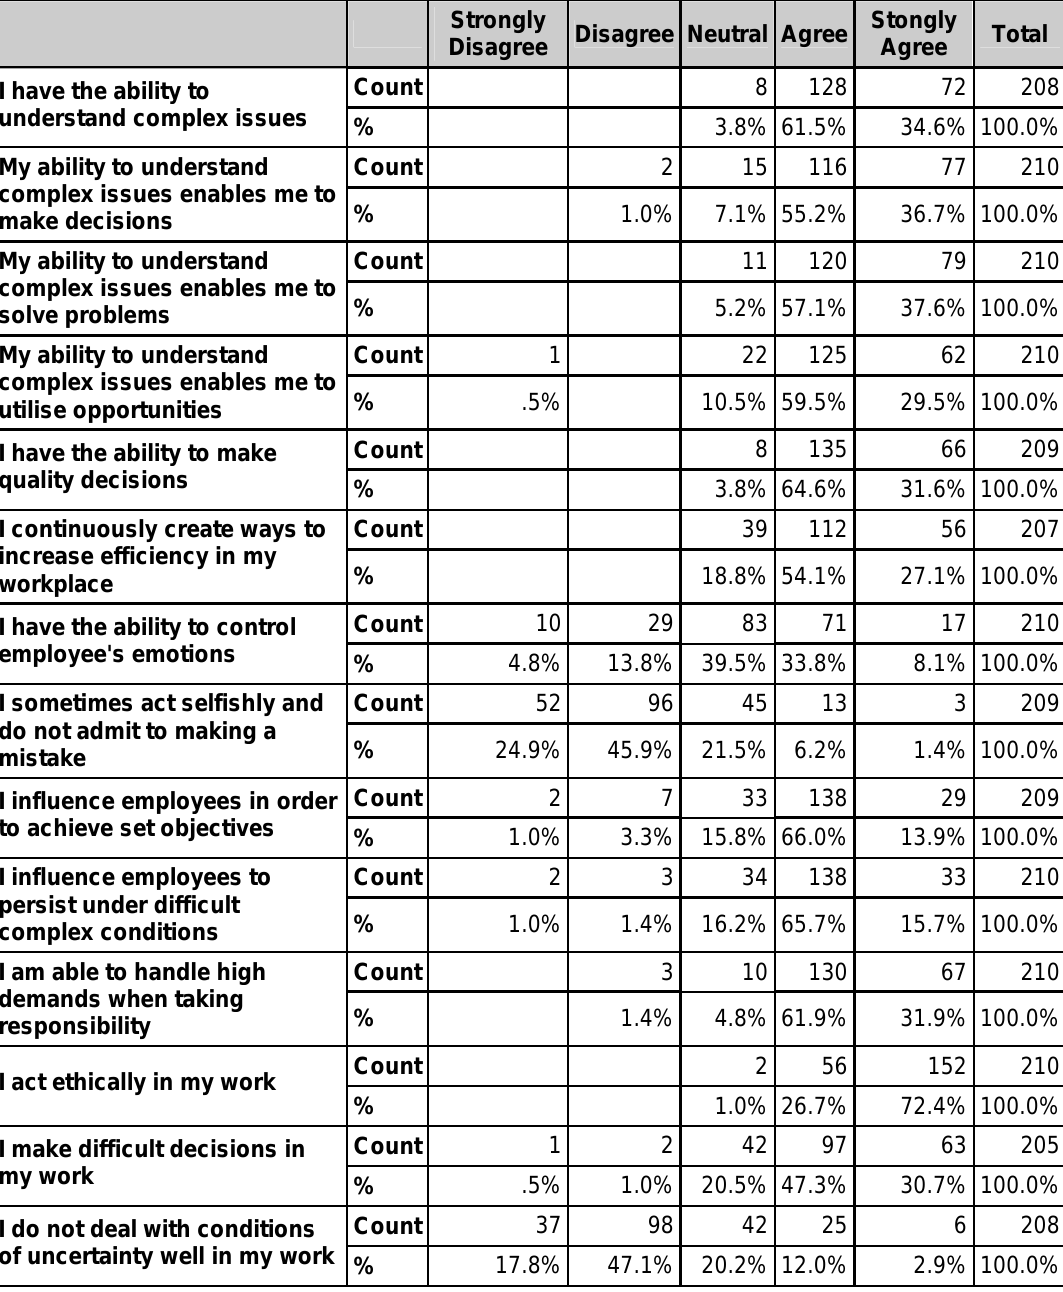
Table 2: Leadership traits